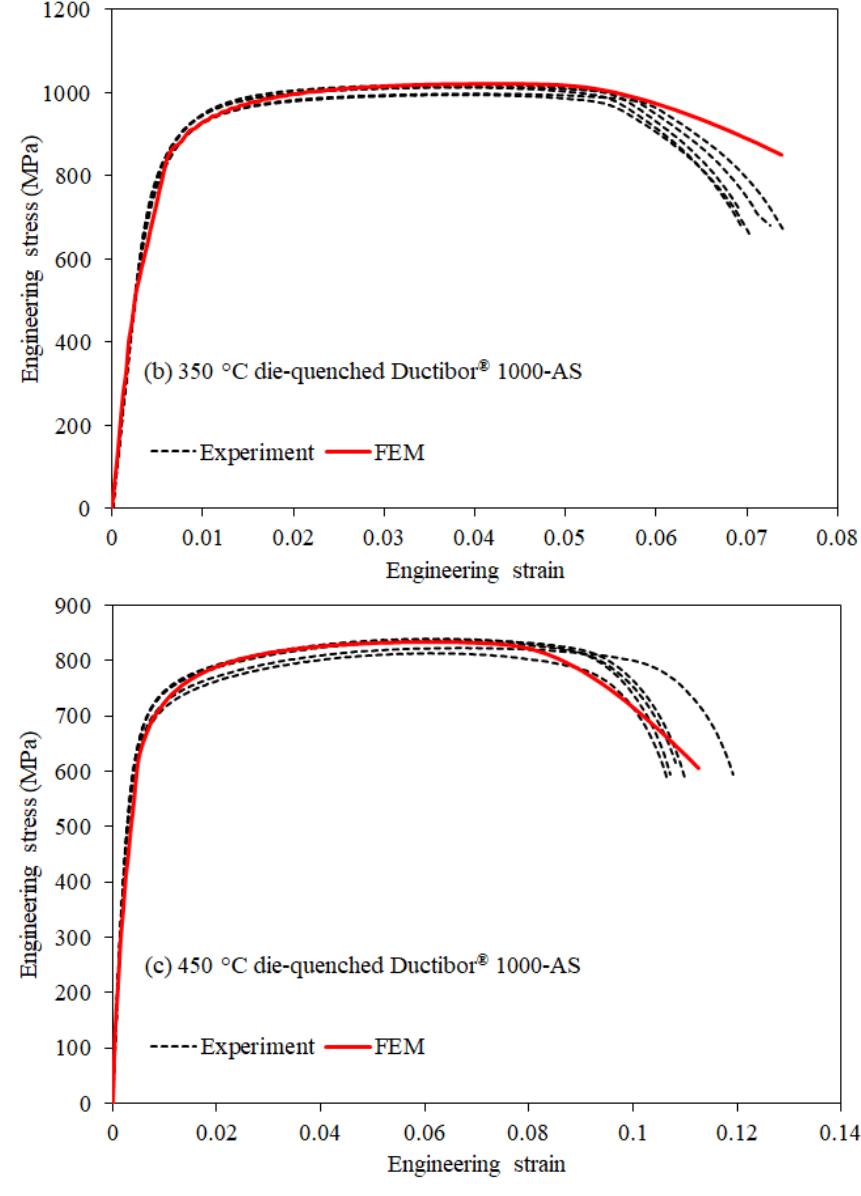
Figure A4. Comparisons of the predicted engineering stress-strain response in various material conditions of Ductibor ® 1000-AS with the experimental data; ( a ) 25 °C ( b ) 350 °C, and ( c ) 450 °C die-quenched conditions.